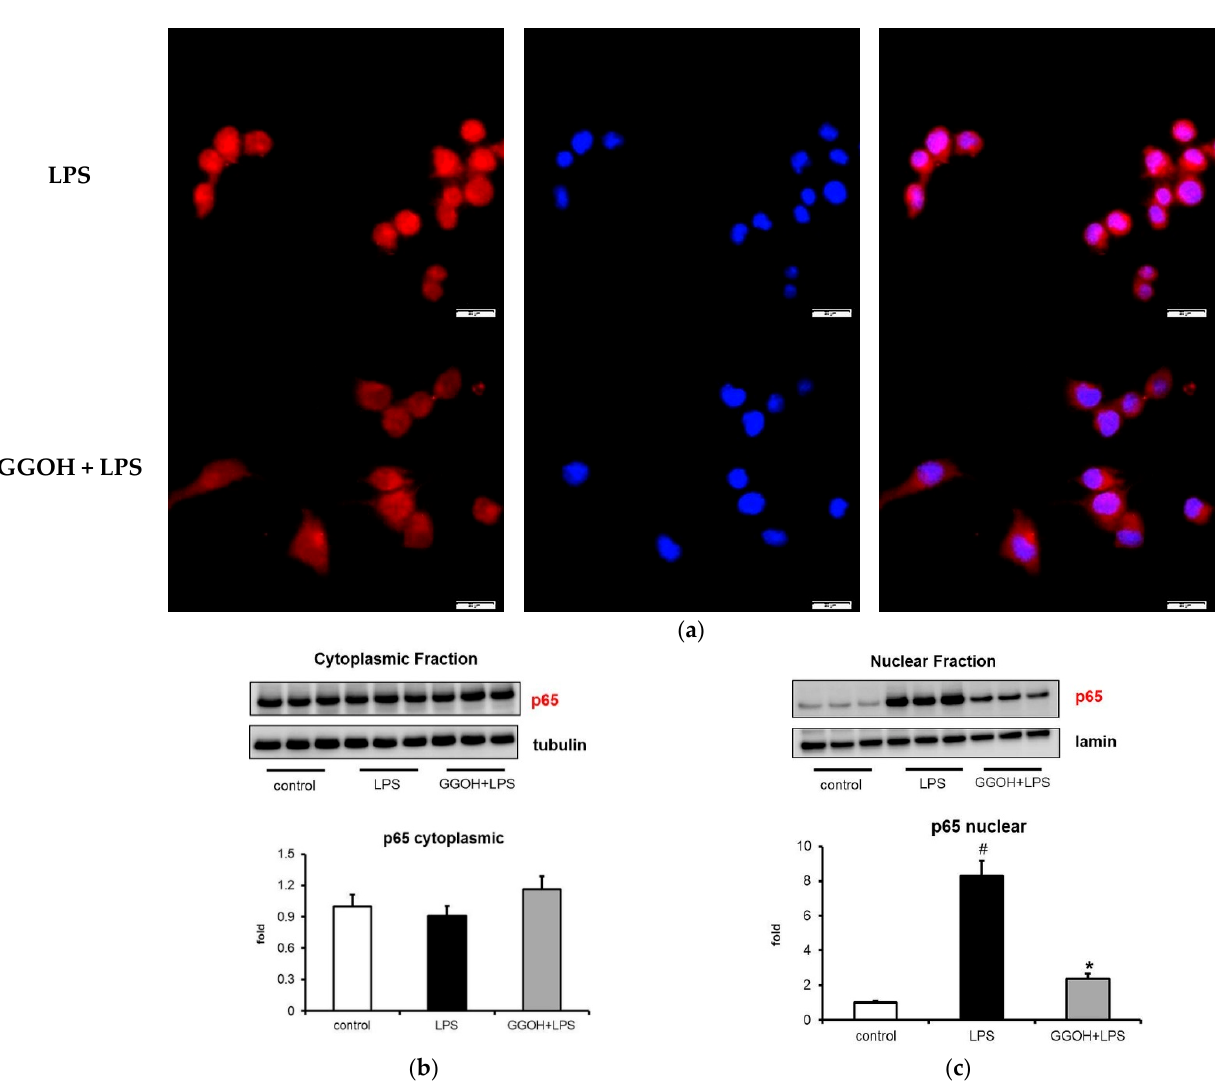
Figure 4. Inhibition of NF- κ B p65 nuclear translocation by geranylgeraniol (GGOH) administration. MG6 cells were pre-treated with GGOH (10 µM) for 24 h followed by LPS treatment (10 ng/mL) for 1 h. ( a ) Cells were fixed and labeled with anti-p65 (red) antibodies. Nuclei were stained with Hoechst 33258 (1 µg/mL) (blue). Scale bars, 20 µm; ( b ) and ( c ) Subjection of the cytoplasmic and nuclear fractions of cells fractionated to Western blot analysis. Data are presented as the mean ± S.E.M, n = 3, normalized to total protein levels based on the use of α -tubulin or lamin, and expressed as the fold-change relative to the values corresponding to the control cells. # p < 0.05 vs. untreated control. * p < 0.05 vs. LPS-only treated group).